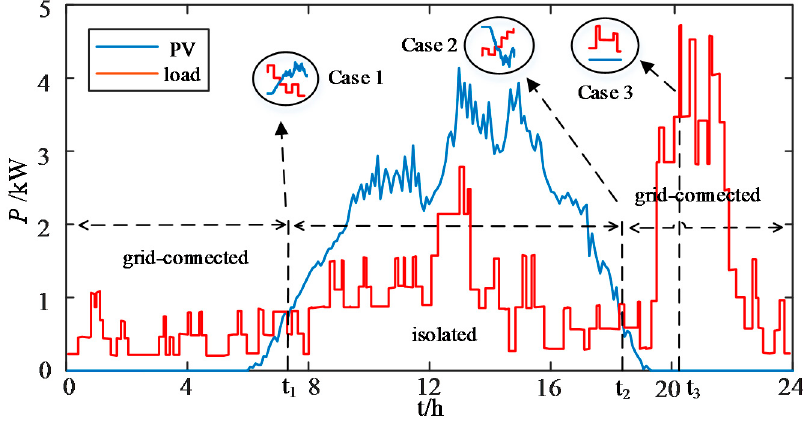
Figure 9. PV generation power and load power curves of energy router in a day.